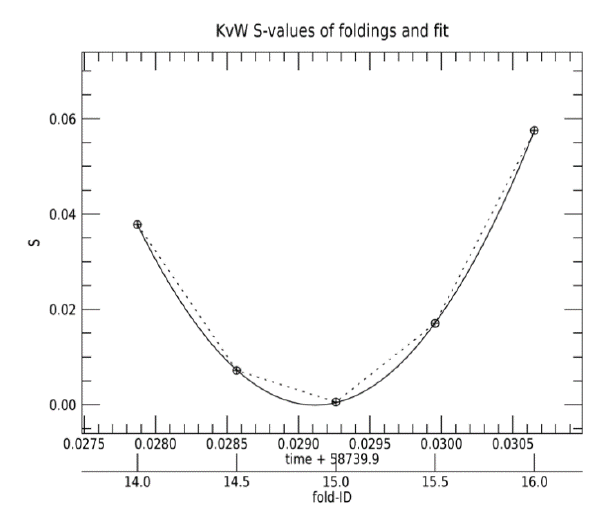
Figure 1. S values (sum of squared differences between fluxes in pairings) for the first complete primary eclipse of CM Dra observed by TESS (see also Figure 2). The upper X axis shows the time in units of BJD-2400000 and the lower one gives the enumeration (‘fold-ID’) of the flux-values on which (or between which) the folding was performed. The circles are S values from five folds at the given fold-ID, while the solid line is the second-order polynomial that is fitted through these points. It should be noted that the minimum of the fitted curve is slightly below